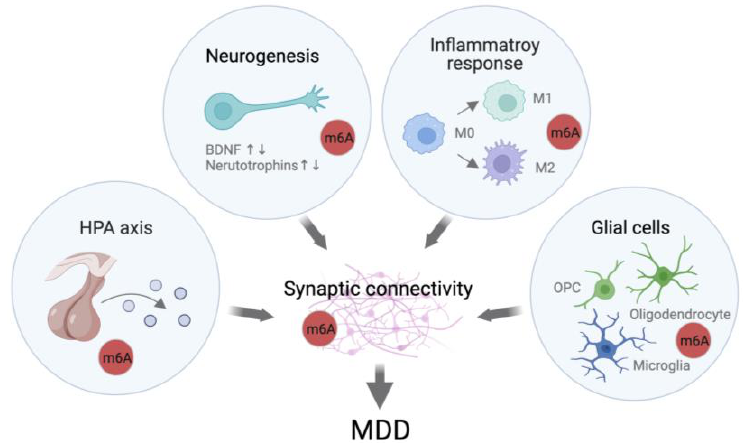
Figure 2. Model for the modulation of synaptic plasticity by m6A resulting in depressive phenotypes. Current literature points toward the role of m6A in biological systems, including the HPA axis, neurogenesis, inflammatory response, and glial functions, which have been implicated in depressive-like behaviors and MDD, suggesting a potential role of m6A in MDD.